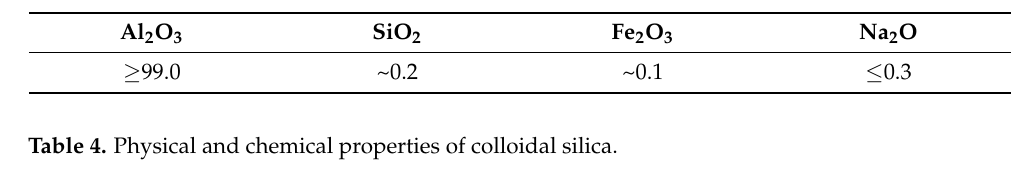
Table 2. Chemical compositions of the Y 2 O 3 powders (mass fraction %).